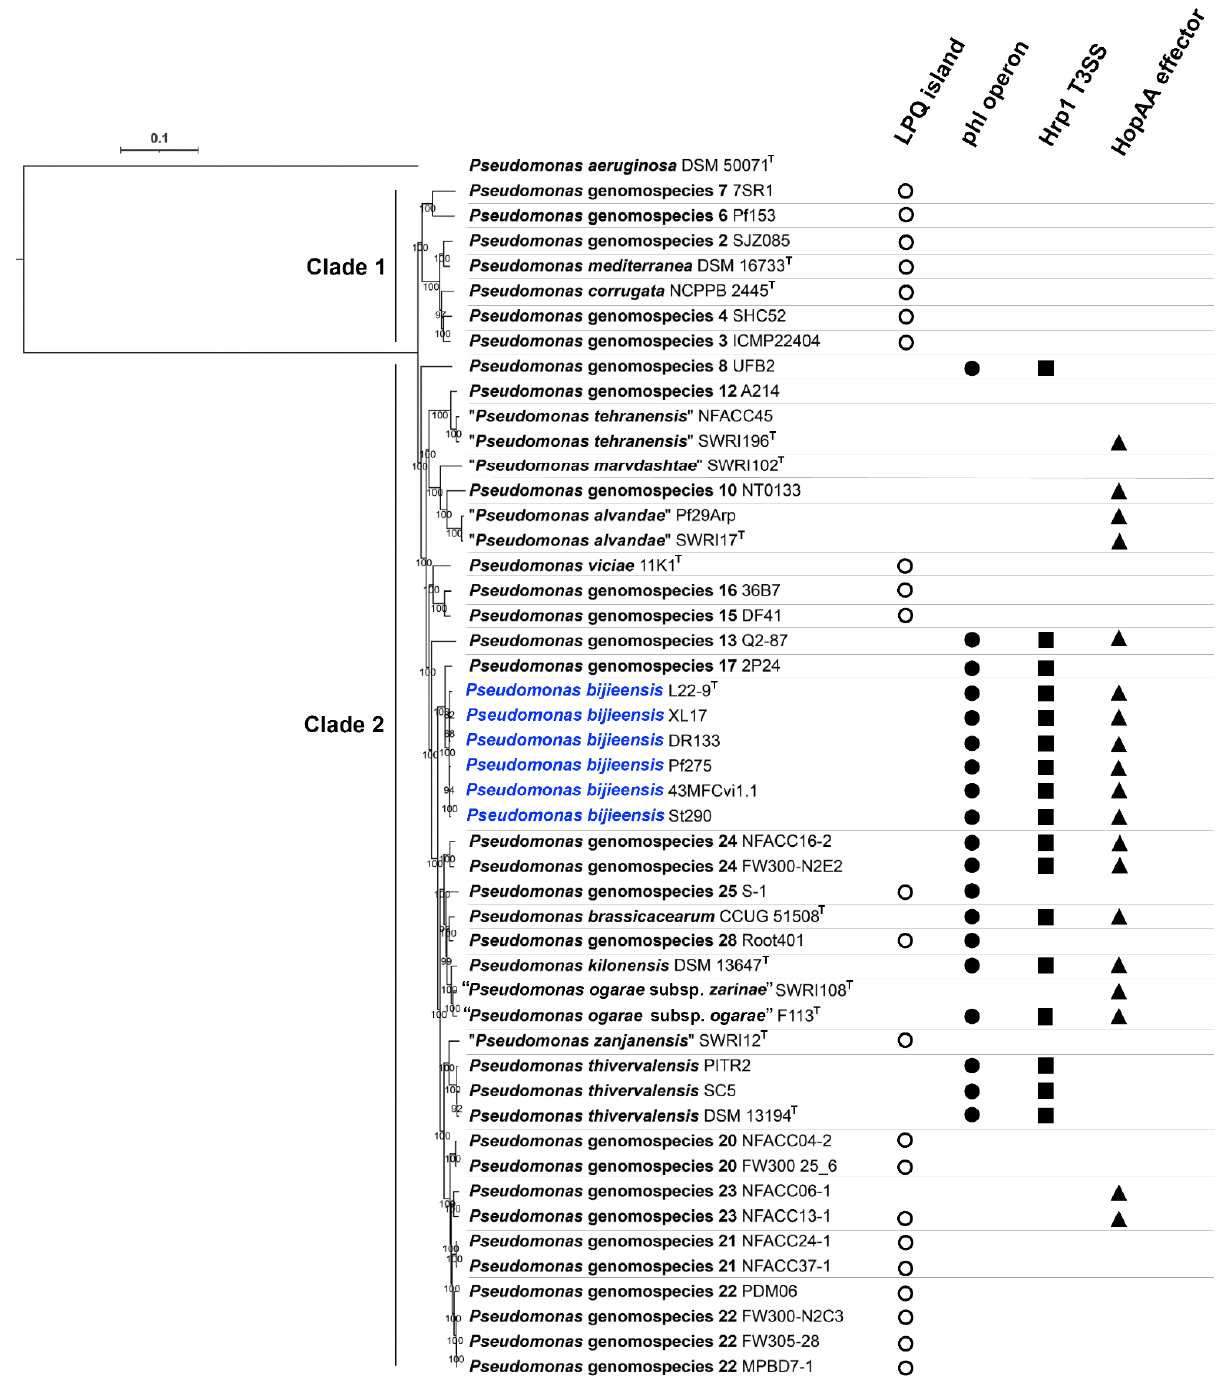
Figure 6. Phylogenomic tree based on concatenated 509,085 amino acid sequences of 1663 core proteins from strains within the Pseudomonas corrugata subgroup and the outgroup strain P. aeruginosa DSM 50071 T . The maximum likelihood tree was generated using IQ-TREE 2.1.2 program with JTT + F + I + G4 model. Bootstrap values of 1000 tests are shown at the nodes. The scale bar indicates 0.1 substitutions per site. The P. corrugata subgroup consists of two monophyletic clades (Clade 1 and Clade 2). Pseudomonas bijieensis is highlighted in blue. Distribution of genetic markers LPQ island ( ◯ ), phl operon ( ● ), Hrp1 T3SS ( ■ ), and HopAA effector ( ▲ ) associated with plant-interaction life styles are labelled after the strain holding the genetic markers.